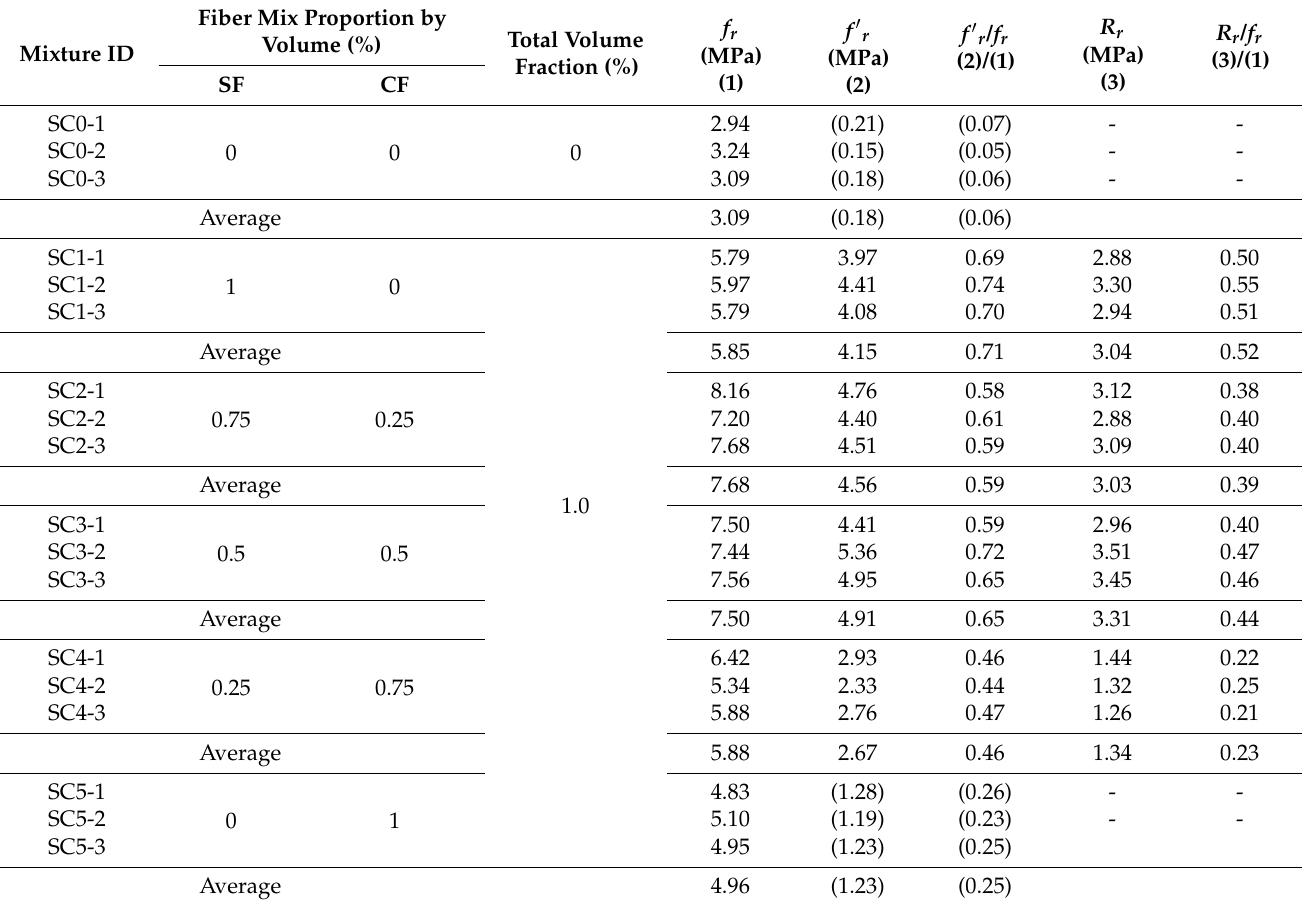
Table 4. Calculation results of equivalent flexural strength and residual flexural strength.